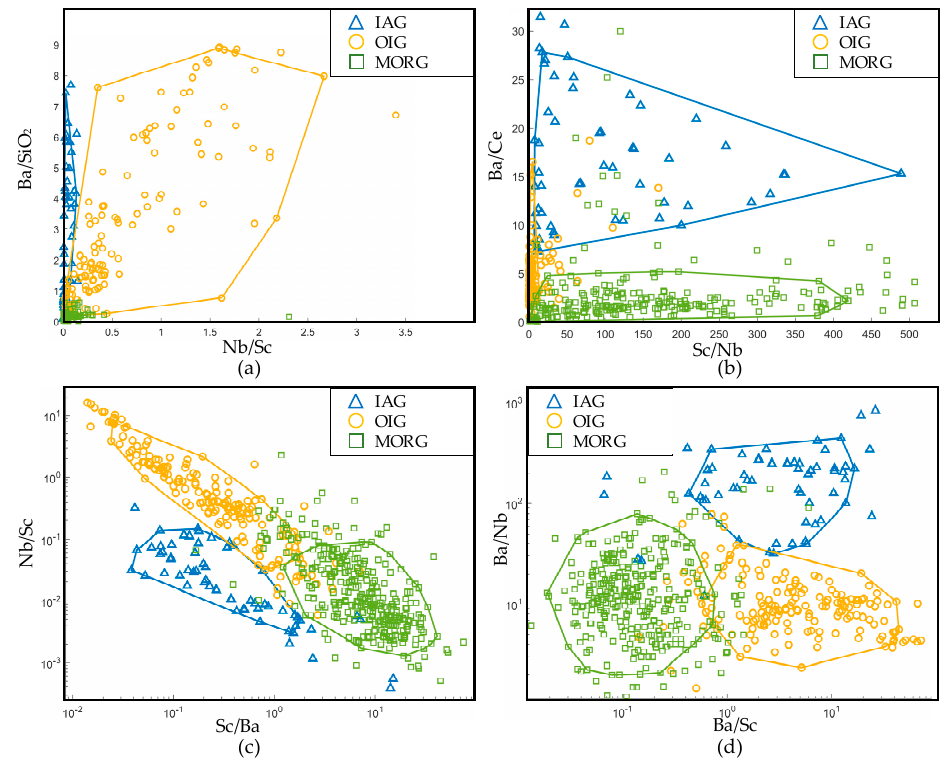
Figure 20. IAG–OIG–MORG discrimination diagrams. All four diagrams have a 0.85 confidence region. ( a , b ) are in linear coordinates; ( c , d ) are in logarithmic coordinates.